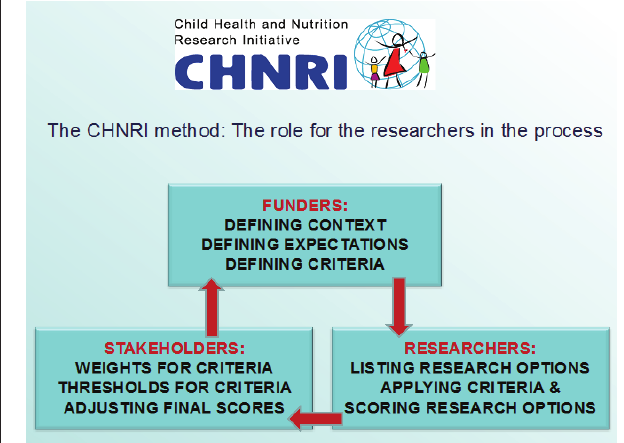
Figure 1. The role of researchers shown within the broader CHNRI